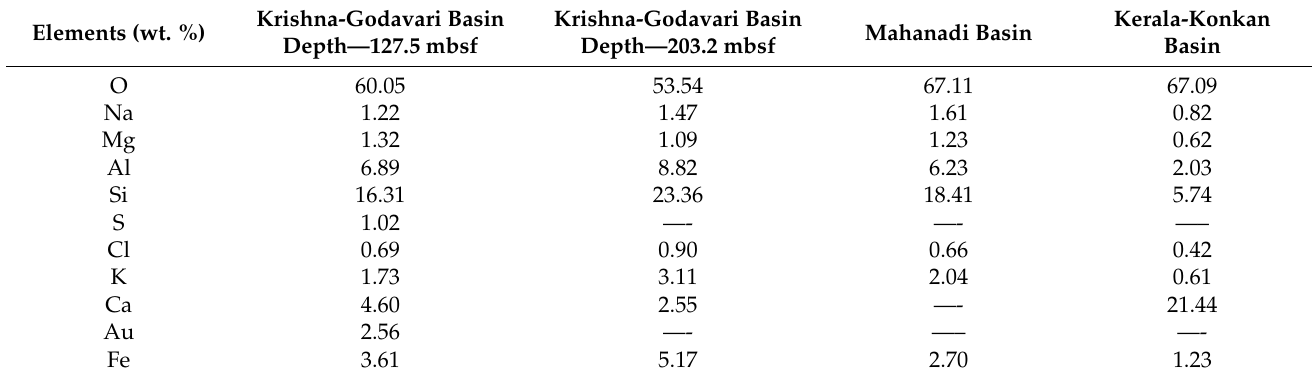
Table 10. Elemental analysis of hydrate-bearing sediment